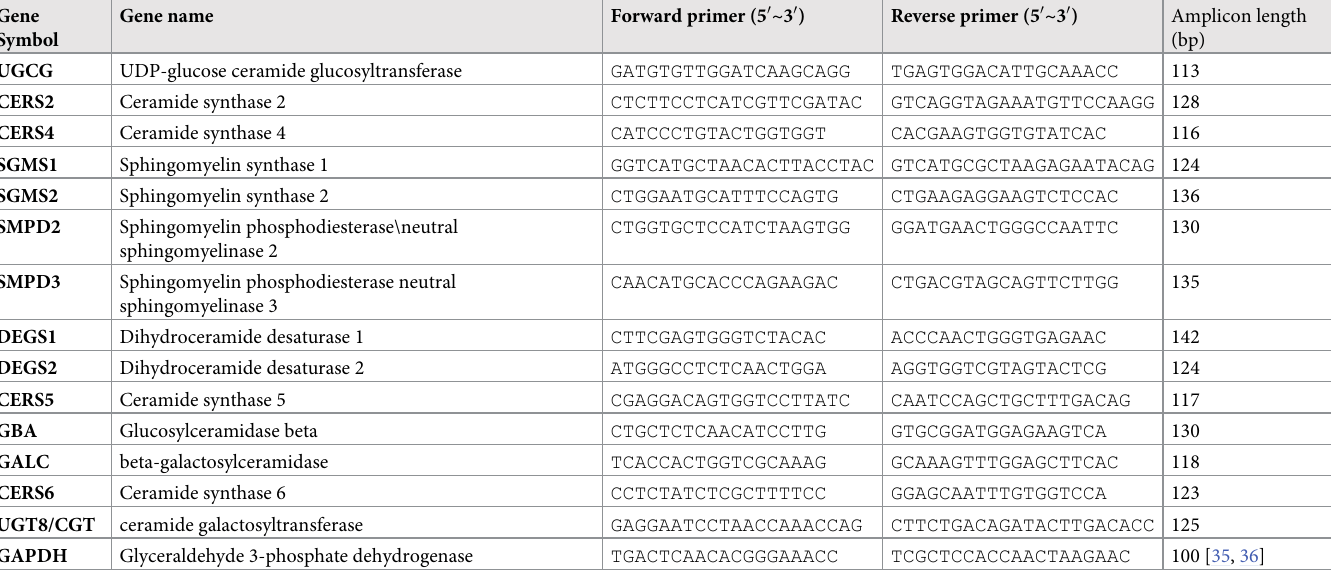
Table 1. List of primers used in